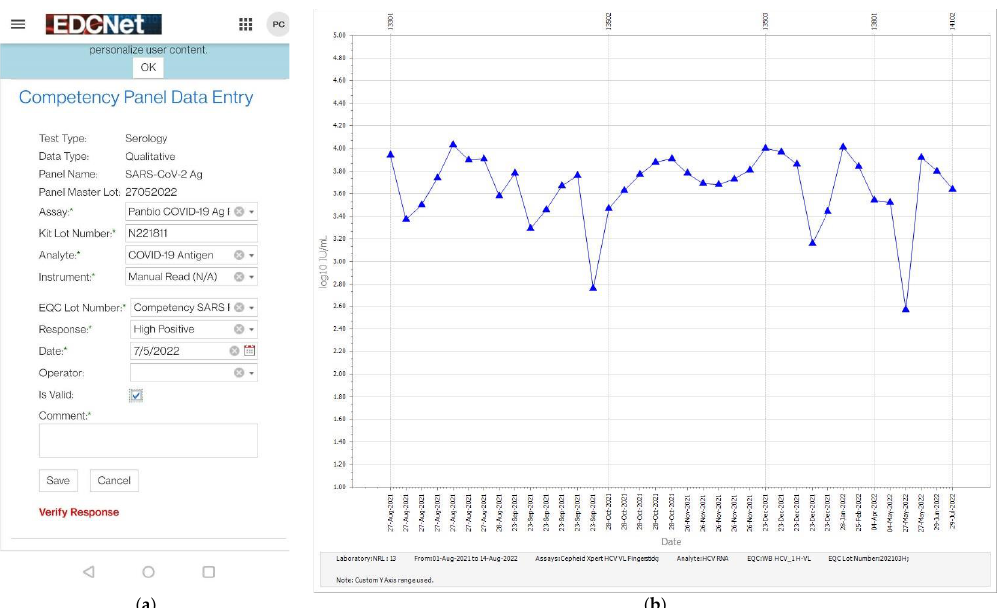
Figure 3. An image of the NRL Competency Panel mobile phone enabled result entry form ( a ) and representative Levey – Jennings Chart representing normal variation over time. X axis indicates the date of testing and Y axis indicates the Log 10 IU/mL result. The change of reagent batch is displayed at the top of the graph. No acceptance limits are represented but would be displayed by horizonal bars across the graph at the upper and lower ranges ( b ).